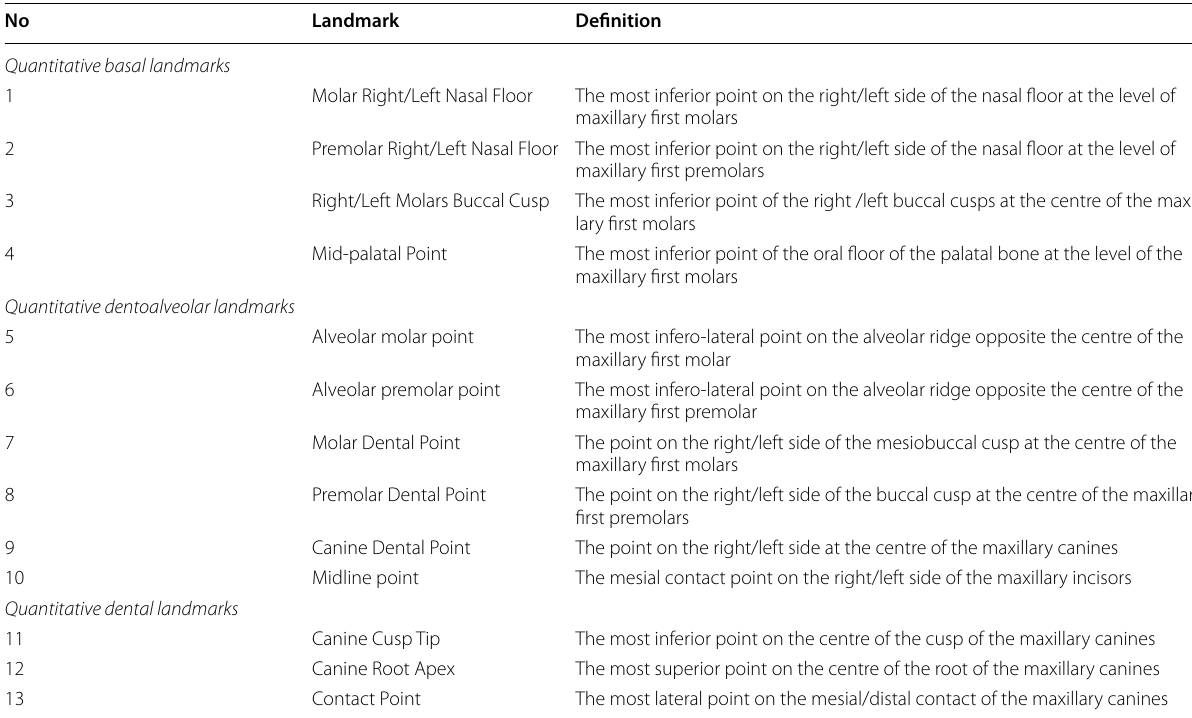
Table 1 Definitions of the anatomical three‑dimensional: skeletal, dentoalveolar, and dental landmarks used in the study No Landmark Quantitative basal